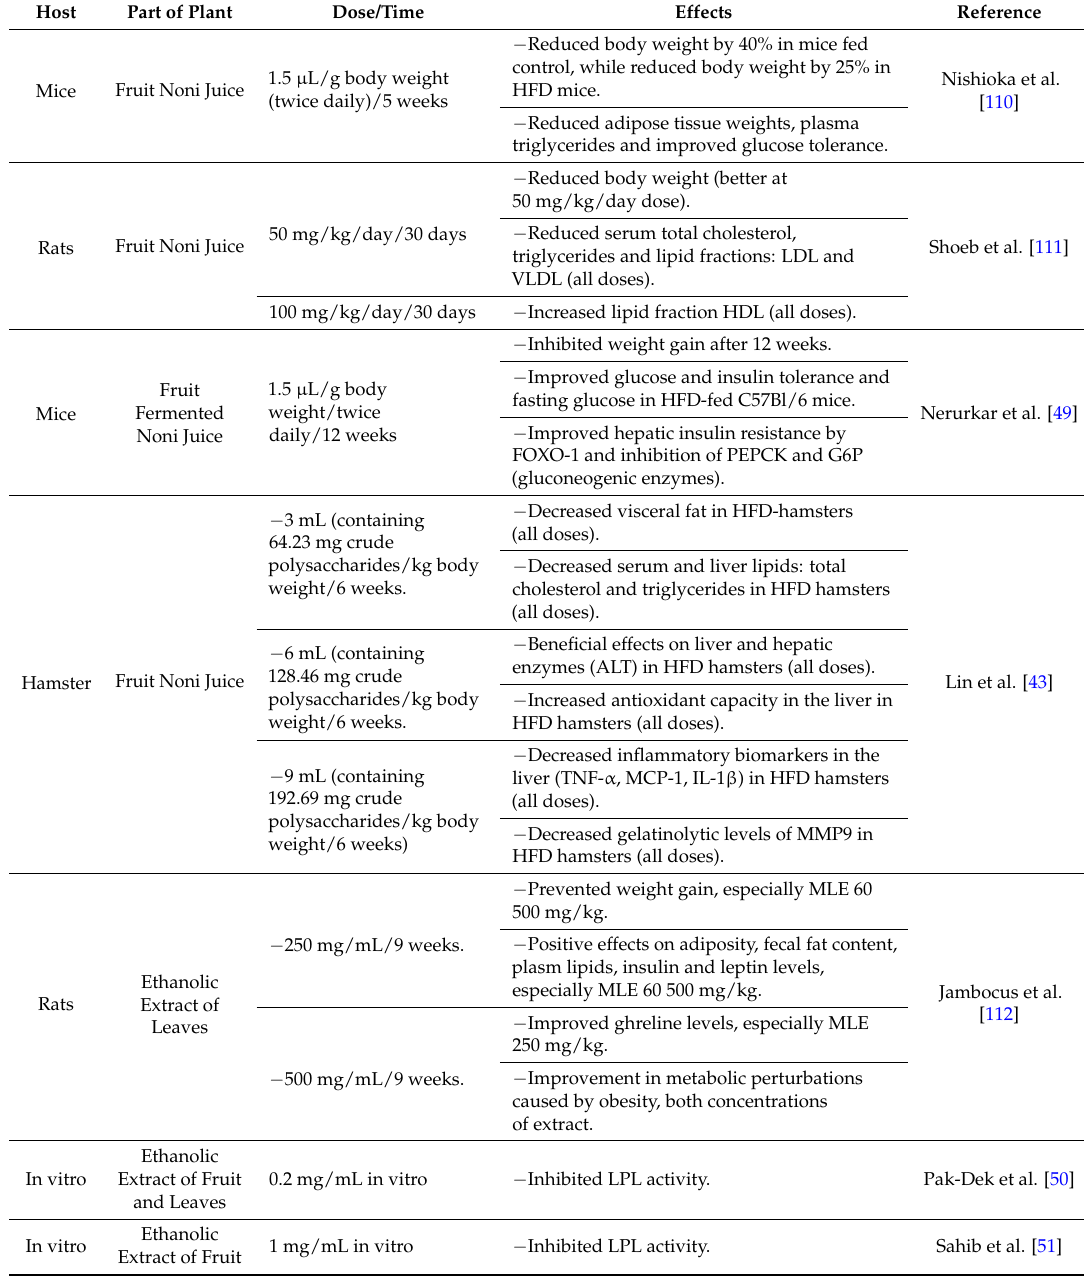
Table 2. The effects of administration of the Morinda citrifolia L. plant on